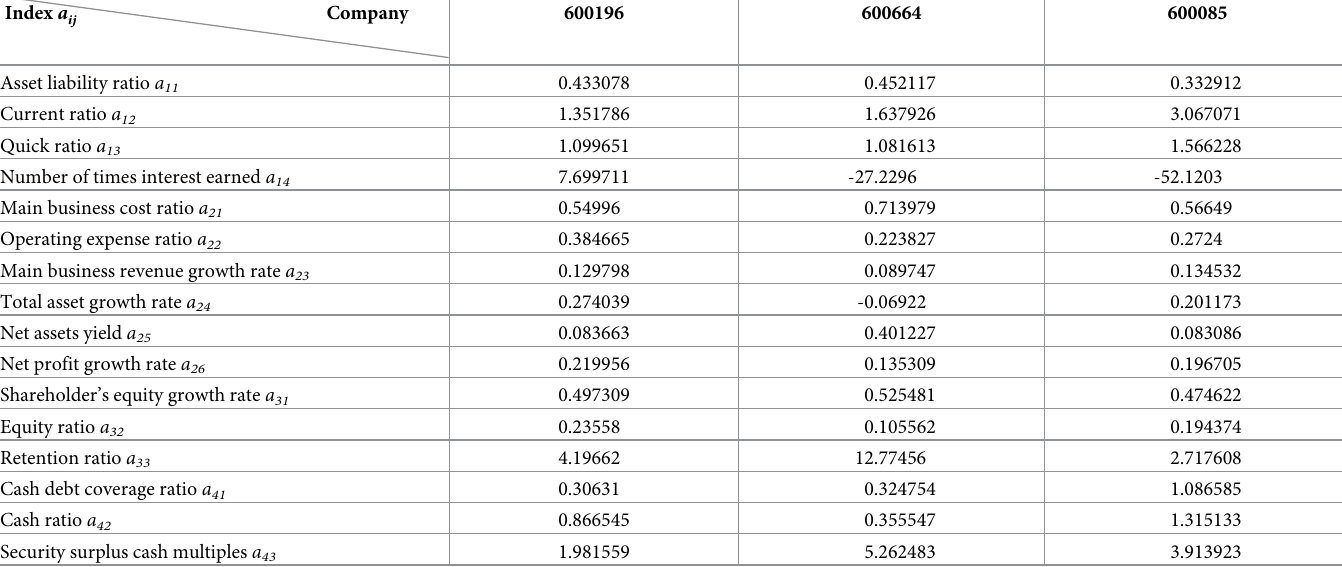
Table 7. Evaluation values of financial risk on quantitative indices.